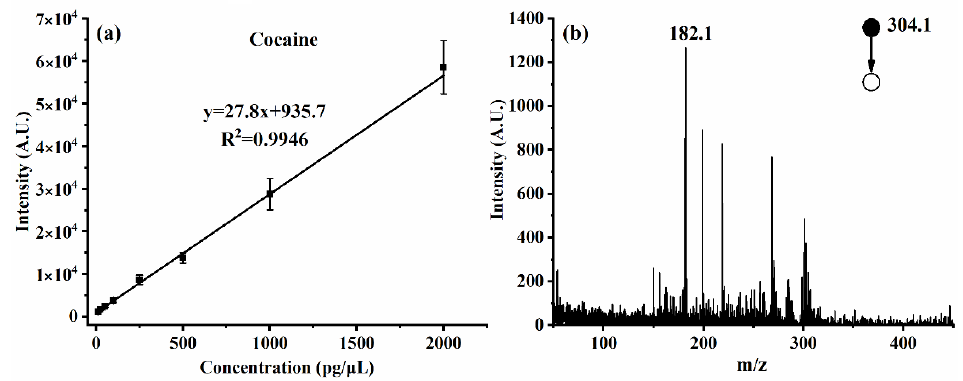
Figure 4. ( a ) Dynamic range of cocaine measured with MS/MS; ( b ) MS/MS spectrum of 10 pg cocaine.